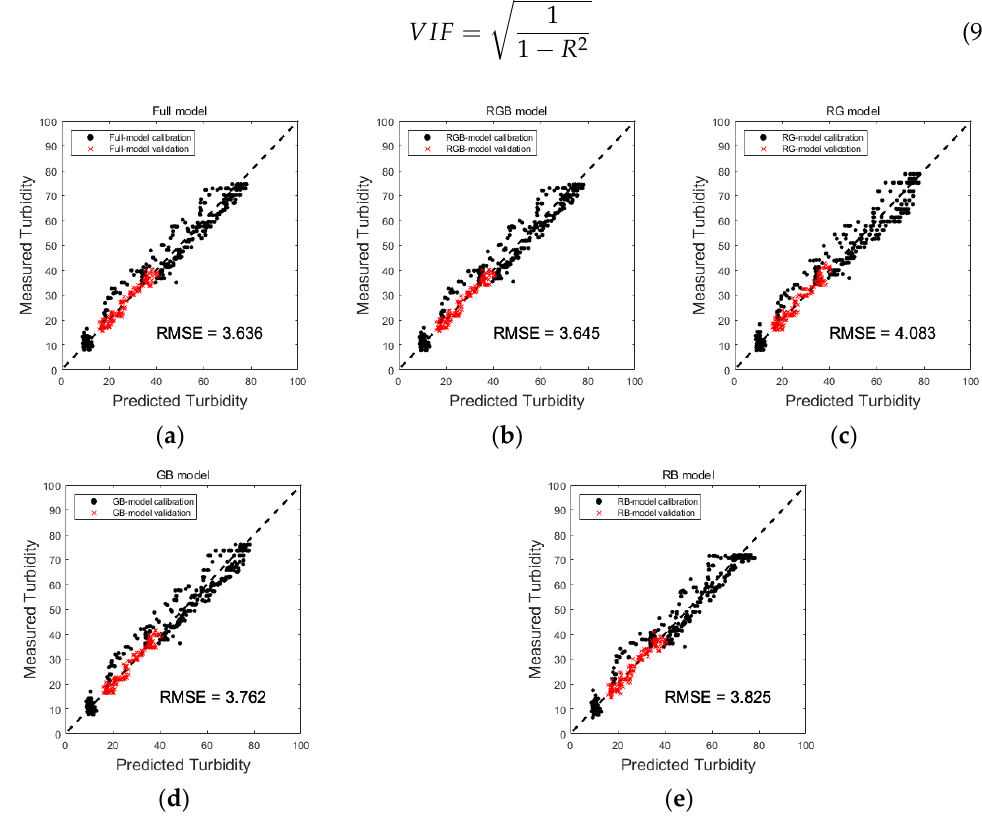
Figure 11. Model verification results: ( a ) RGB Gray scale model, ( b ) RGB model, ( c ) RG model, ( d ) GB model and ( e ) RB model. Table 2. Results of multicollinearity assessment for the developed